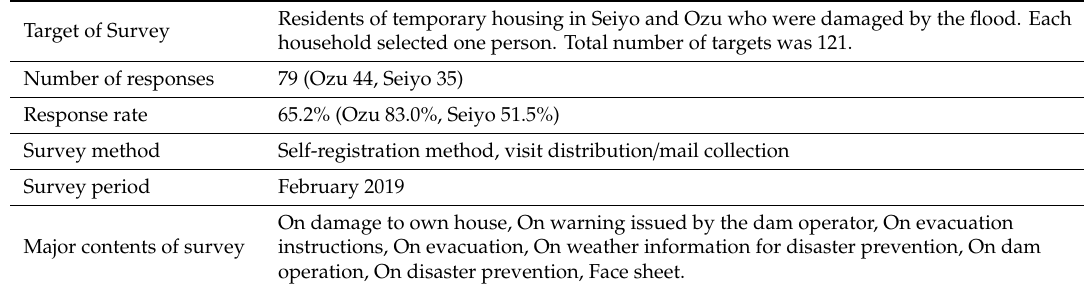
Table 4. Overview of the questionnaire